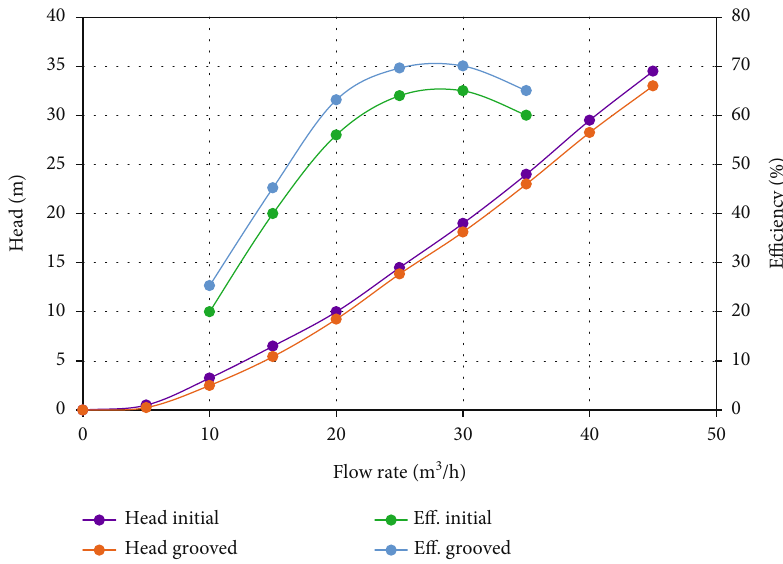
Figure 14: The in fl uence of blade grooving on PAT e ffi